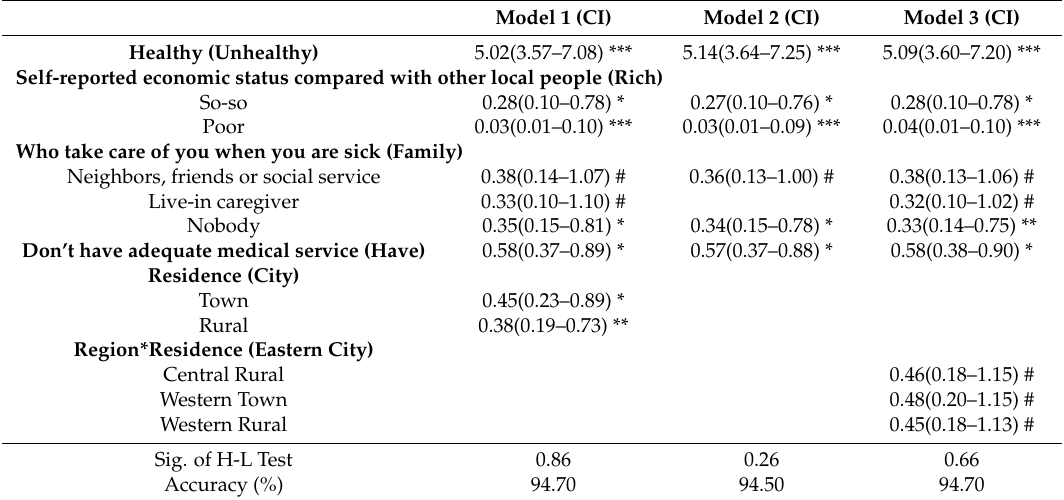
Table 3. Binary logistic regression for odds ratios of self-reported QoL (Bad QoL as reference).